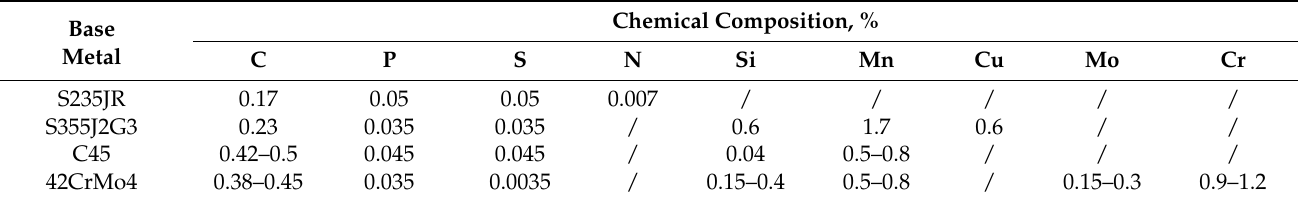
Table 2. Chemical composition of the tested steels [1].